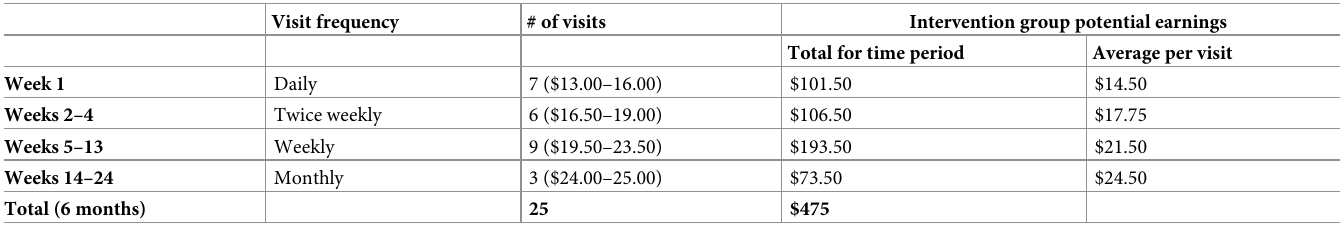
Table 1. Escalating contingency management schedule for intervention group �